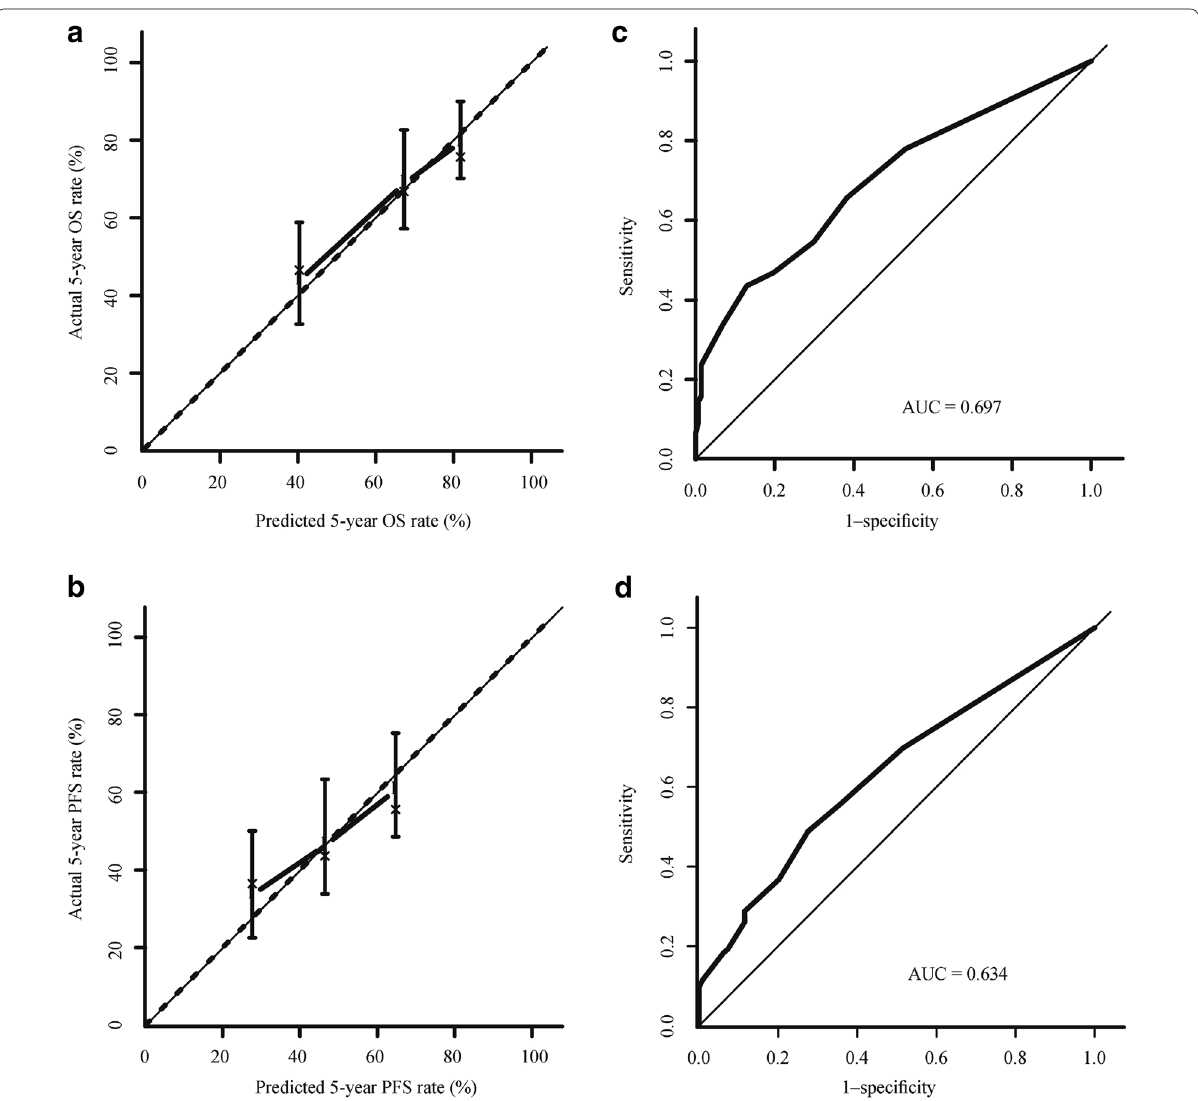
Fig. 5 Internal validation of the nomogram used to predict OS and PFS in patients with upper aerodigestive tract nasal‑type extranodal natural killer/T‑cell lymphoma. Discrimination and Calibration: Calibration plot for predicting 5‑year OS rate ( a ) and 5‑year PFS rate ( b ). The areas under the receiver operating characteristic curve are 0.697 for 5‑year OS rate ( c ) and 0.634 for 5‑year PFS rate ( d ). The nomogram‑predicted survival is plotted on the X axis ; the actual survival is plotted on the Y axis . AUC area under the